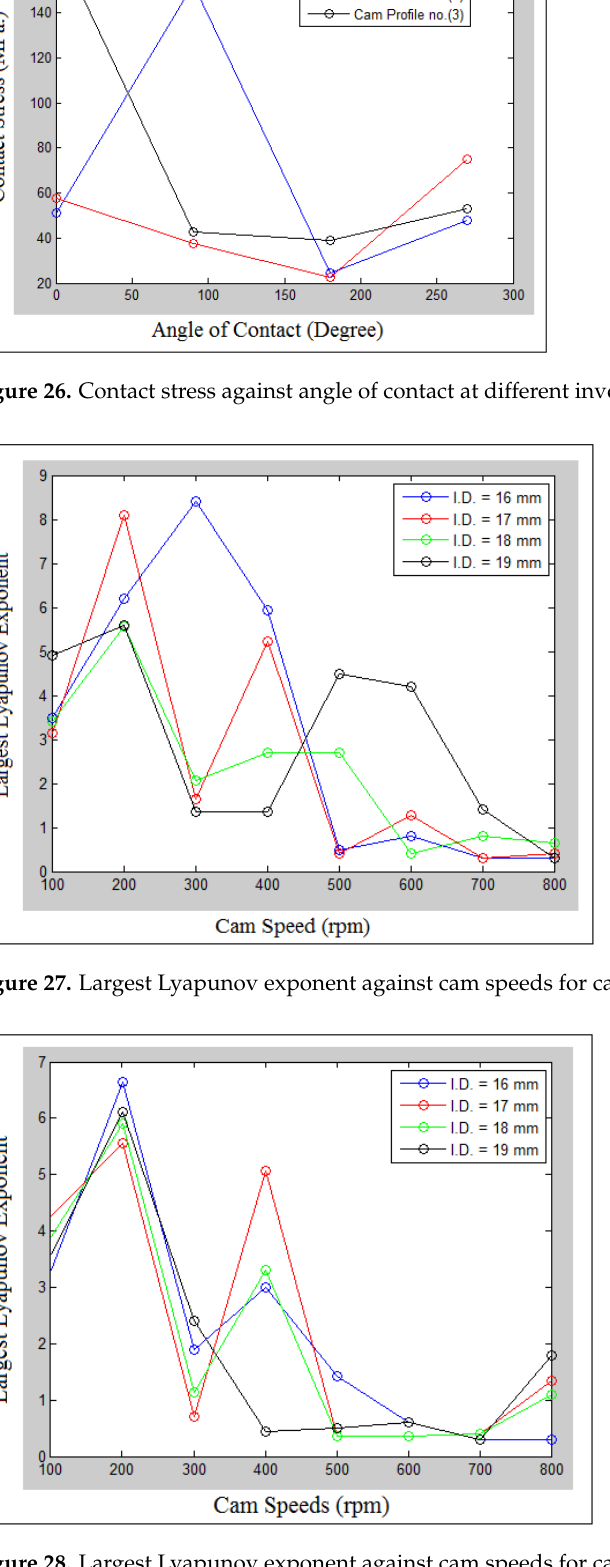
Figure 28. Largest Lyapunov exponent against cam speeds for cam profile no.(2). Figures 30 and 31 show the phase-plane mapping of the fringe order of the contact stress at different cam speeds (N) and different internal distances of the follower guide from inside (I.D.) for cam profile no.(2) and cam profile no.(3). It can be concluded from the phase-plane diagram that the motion of the contact stress is periodic since the attractor of the fringe order is one closed cycle as indicated in Figures 30a and 31a. The other sys- tems indicate non-periodic motion and chaos since the attractor of the fringe order of the contact stress diverges with no limit of spiral cycles. In general, the cross-linking of the fringe order of the contact stress is increased with the increasing of cam speeds (N) and internal distance of the follower guide from the inside (I.D.).